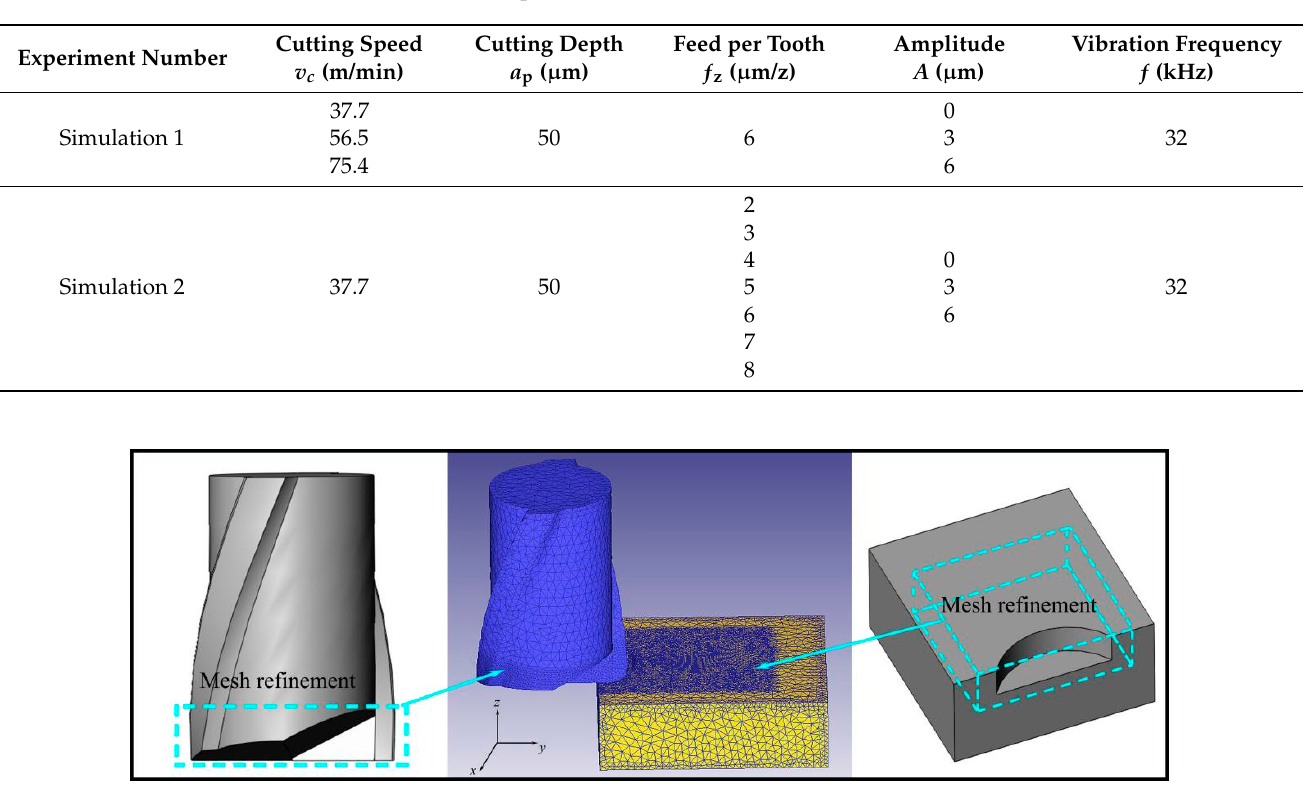
Table 2. Simulation parameters.